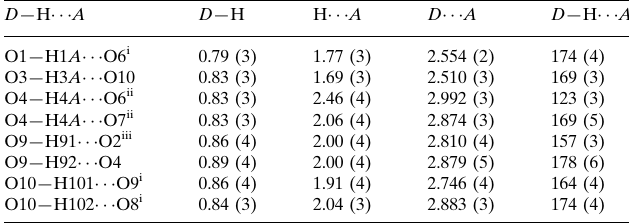
Hydrogen-bond geometry (A˚ , (cid:2)